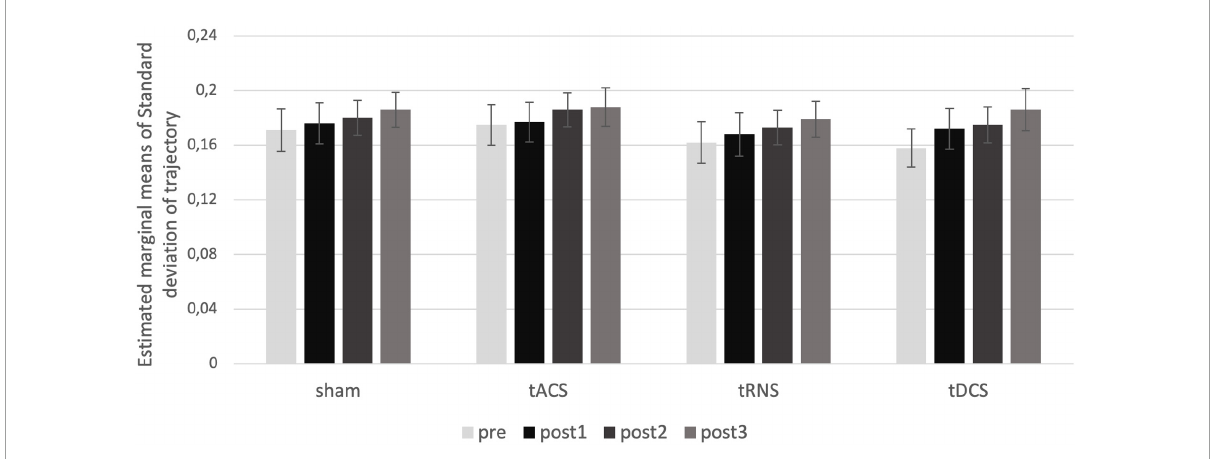
FIGURE4 Intervention effect on movement trajectories. Estimated marginal means of standard deviation for the interaction of the factors TIME and INTERVENTION are shown. There is no effect of intervention over time. post1 = 15 min; post2 = 55 min; post3 = 95 min post intervention.